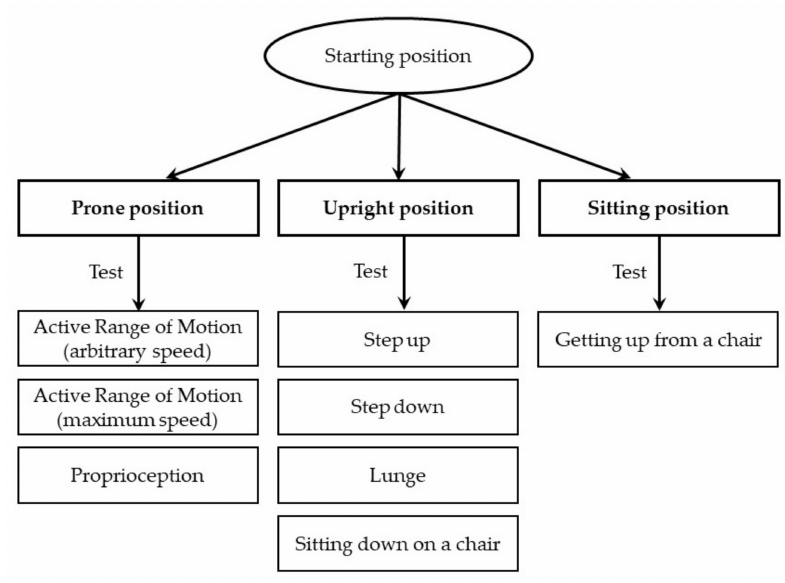
Figure 2. Presentation of eight tested